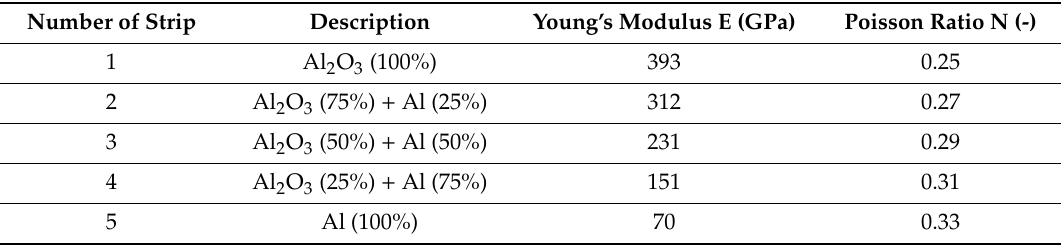
Table 1. Mechanical properties for detailed